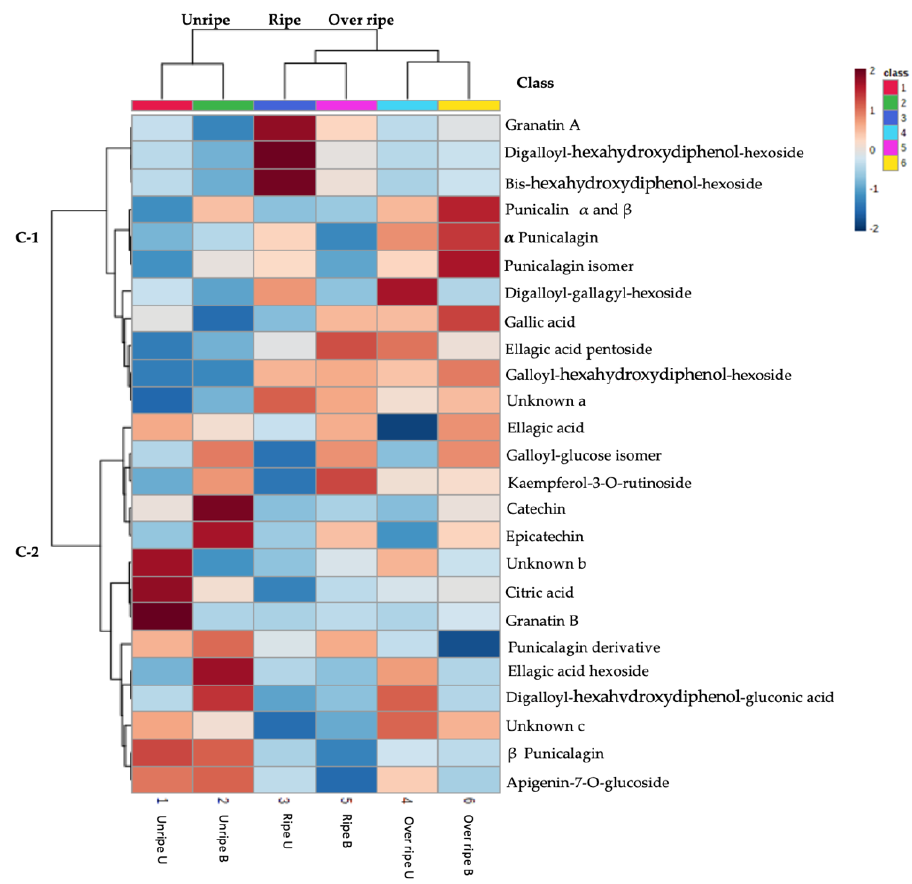
Figure 2. Heat map showing phenolic compound distribution and concentration between the harvest maturities (unripe, ripe, and over ripe) of ‘Wonderful’ pomegranate peel extracts. The red boxes mean concentrations are higher among different pomegranate fruit samples. The blue boxes show lower concentrations. Unripe, ripe, and over ripe harvested two weeks before commercial harvest, at commercial harvest and two weeks after commercial harvest, respectively. Letters U and B represent unblanched and blanched pomegranate peel extracts at 80 °C for 3 min, and C represents the cluster(s).